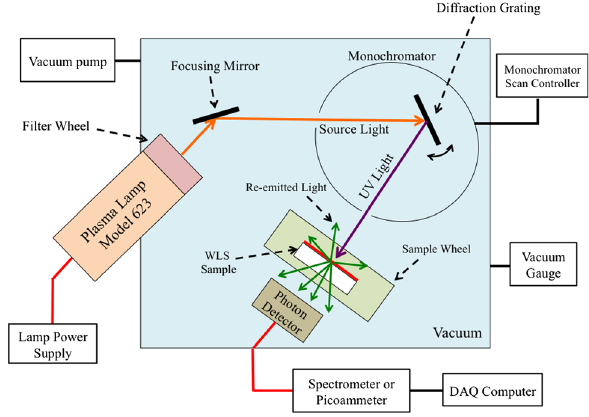
Fig. 2 A cartoon schematic of the experimental setup for the long wavelength configuration (Sect.